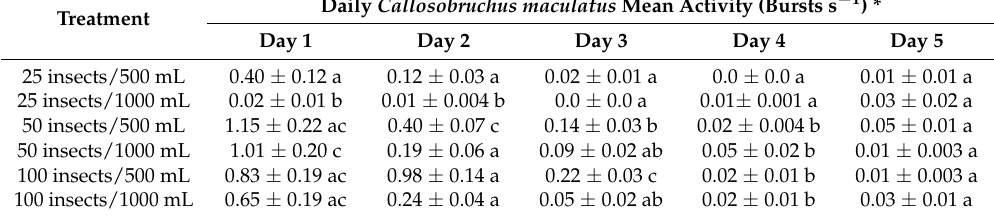
Table 3. Analysisofvarianceofinsectsoundburstratesproducedby25, 50, and100 Callosobruchusmaculatus adults during the first five days of hermetic storage treatment in 500 mL and 1000 mL jars ( n = 324).